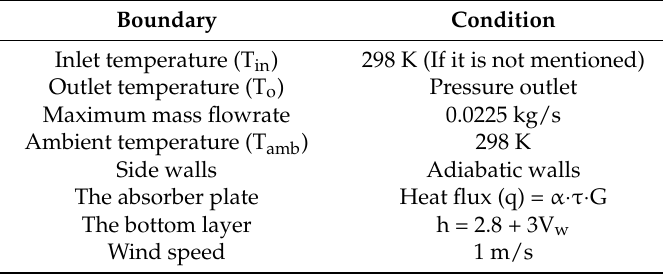
Table 2. Boundary conditions for the FPC.